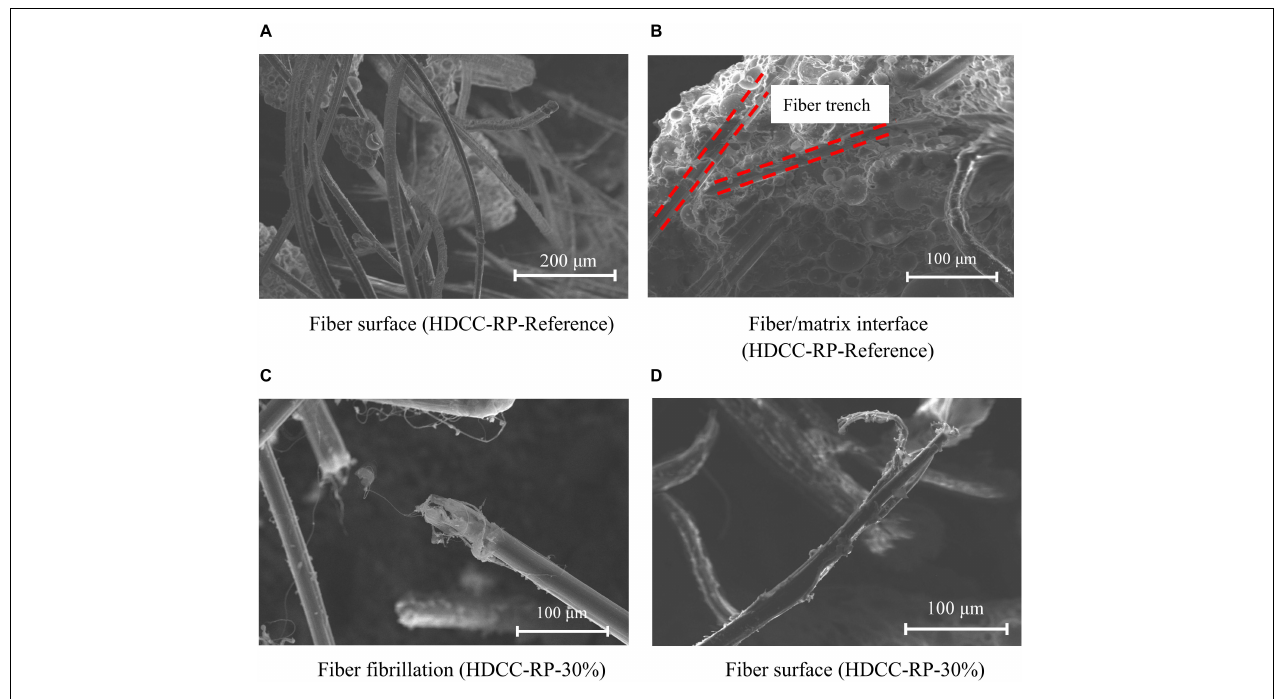
FIGURE 12 | Morphology of HDCCs. (A) Fiber surface (HDCC-RP-Reference). (B) Fiber/matrix interface (HDCC-RP-Reference). (C) Fiber fibrillation (HDCC-RP-30%). (D) Fiber surface